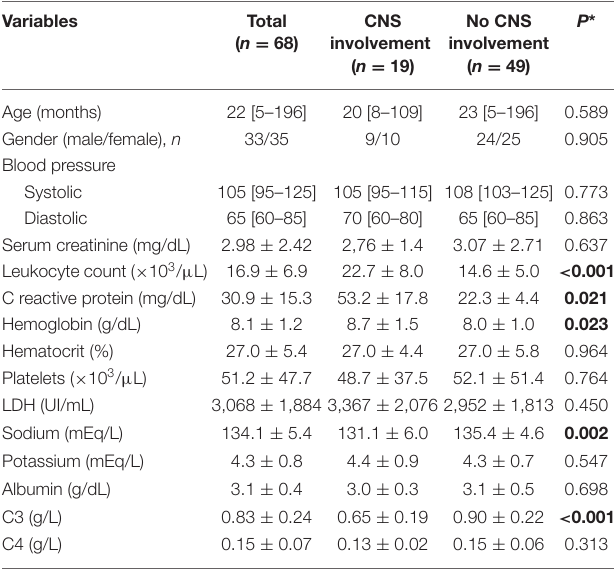
TABLE 2 | Clinical and laboratory characteristics of STEC-HUS patients with and without central nervous system (CNS) involvement.